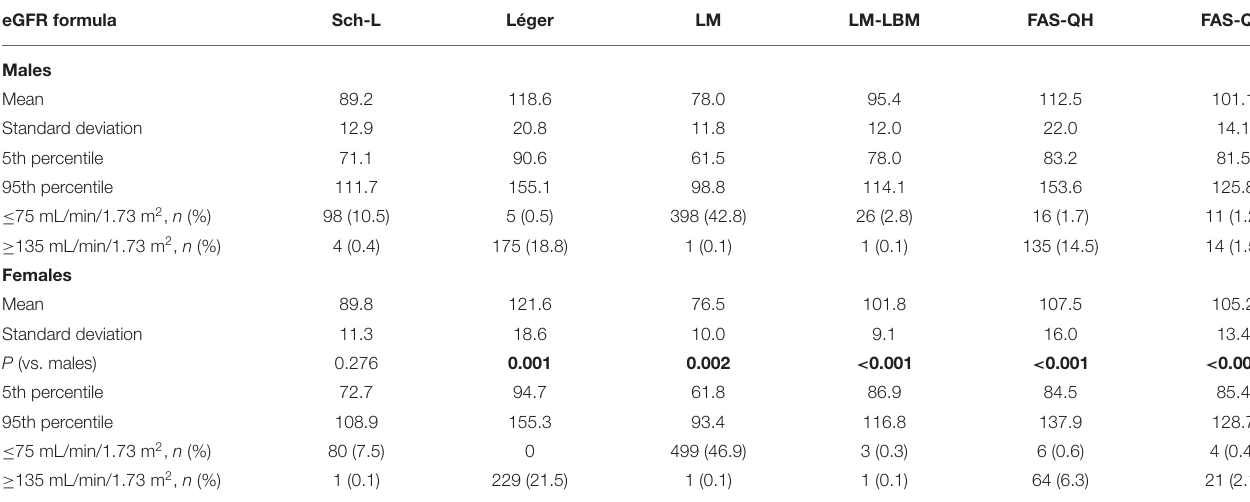
TABLE 2 | Descriptive characteristics of estimated glomerular filtration rate returned by six creatinine-based formulae in males and females. eGFR